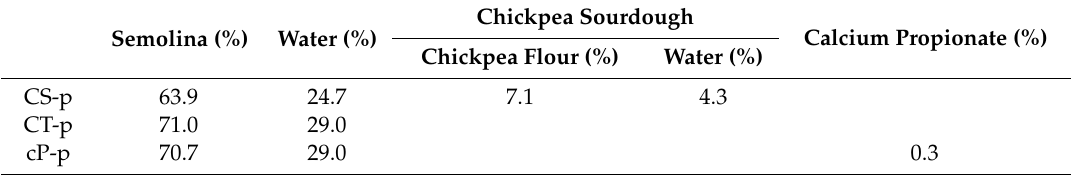
Table 1. Formulas of fresh pasta: CS-p, pasta containing 10% (w / w) fermented chickpea sourdough; CT-p, semolina fresh pasta; and cP-p, semolina fresh pasta added of 0.3% (w / w on flour weight basis) calcium propionate. Semolina (%) Water